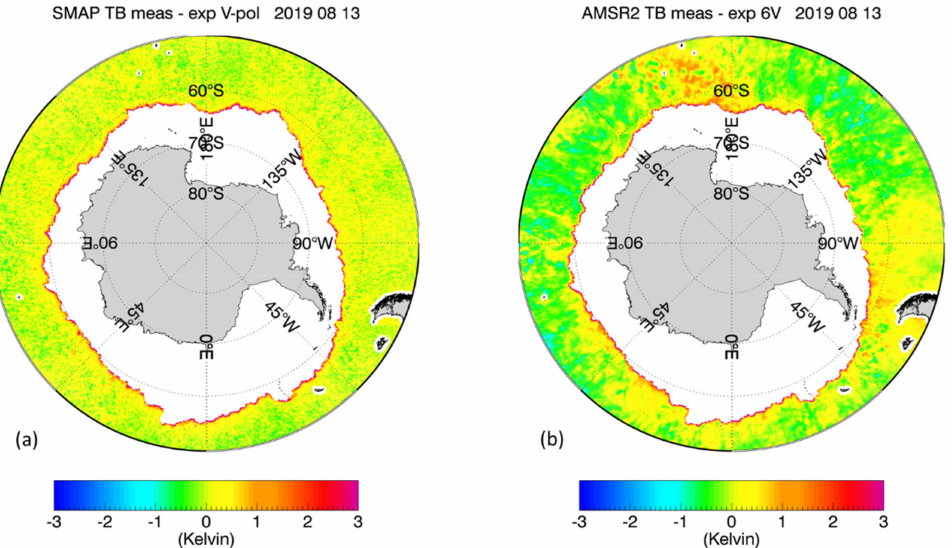
Figure 1. 8-day average TB biases near the Antarctic sea-ice edge for a scene during the Austral winter (13 August 2019) ( a ) SMAP V-pol; ( b ) AMSR2 6.93 GHz V-pol channel. The TB bias is defined as the difference between measured and expected (computed) specular surface TB. The sea-ice contamination results in a positive TB bias for both SMAP and AMSR2 near the ice edge, which results in a fresh (negative) bias in the retrieved